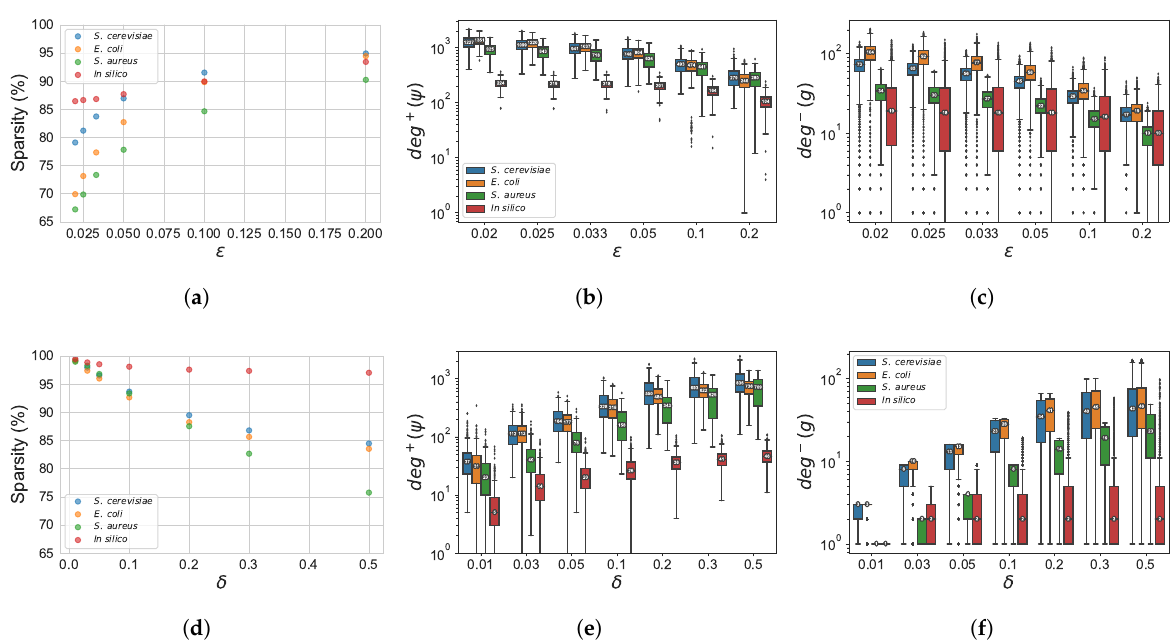
Figure 2. Sparsity of the networks inferred by the GXN•EN ( a )) and the GXN•OMP ( d )) methods.